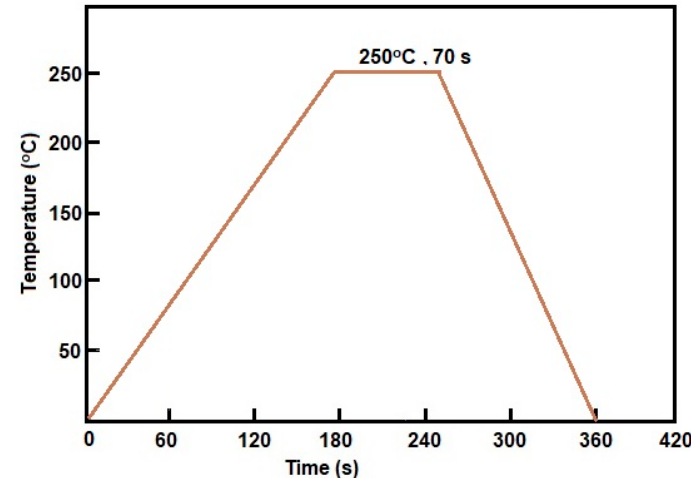
Figure 5. The reflow profile for the measurement of the solderability of the Sn-0.7Cu alloy.